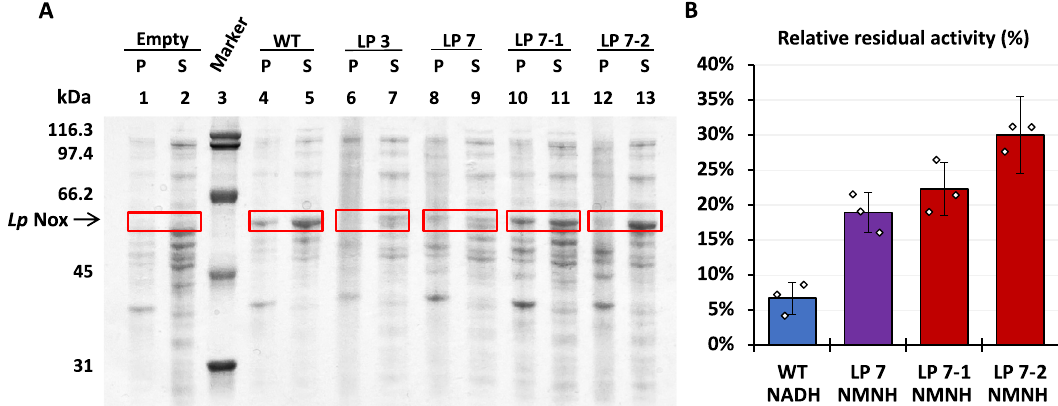
Fig. 3 | Variants selected from the second round of growth selection display increased solubility and thermostability. A SDS -PAGE analysis of protein solu- bility. The insoluble pellet (P) and supernatant (S) fractions obtained through centrifugationfollowingcelllysisareevaluatedforNoxexpressionlevel.VariantLP 7-1 and LP7-2show increasedsolubilityfraction(lane10/11and12/13)comparedto LP7(lane8/9).WT Lp Nox(lane4/5)andemptyplasmidharboringsamples(lane1/ 2) serve as controls. B Relative residual activity before and after heat treatment. After 23h of heat treatment at 50°C, WT (blue) activity with native cofactor was